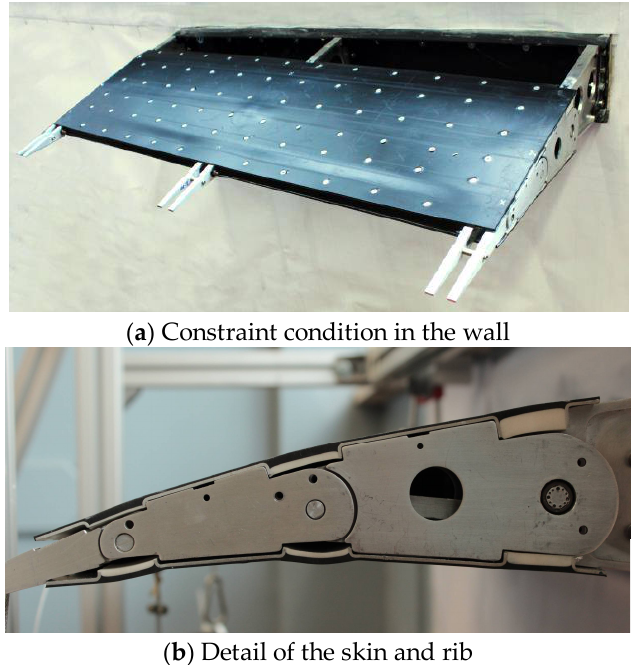
Figure 20. Test article in clamped conditions.